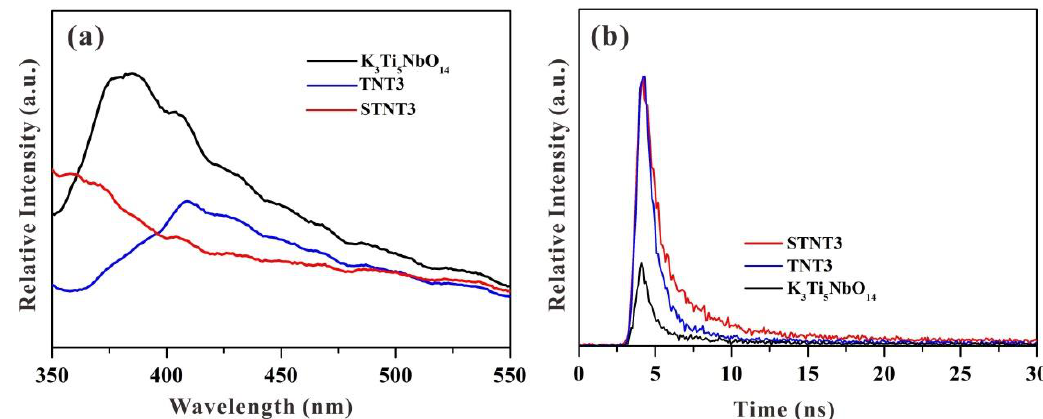
Figure 9. ( a ) Photoluminescence (PL) spectra with an excitation wavelength of 325 nm and ( b ) time- resolved transient PL decay spectra for K 3 Ti 5 NbO 14 , TNT3, and